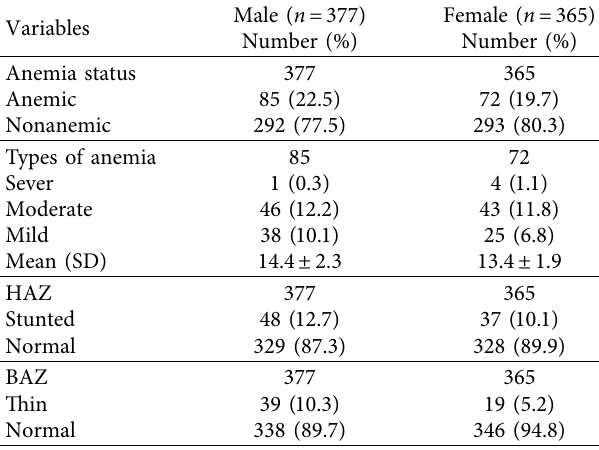
Table 4: Prevalence of anemia among male and female adolescents in Dilla Town, Southern Ethiopia, May